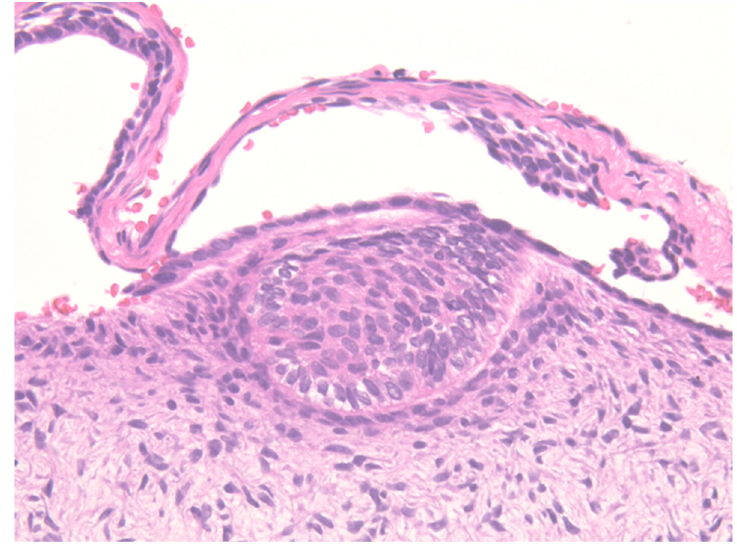
Figure 4. Histological findings of primordial odontogenic tumor. Nests of epithelium resemble dental lamina, and columnar epithelial cells show reverse nuclear polarization (200×). Immunohistochemistry revealed vimentin expression in the epithelium and mes- enchymal component, whereas syndecan-1 (CD138) and Bcl-2 were not expressed in the epithelium and mesenchymal component (Figure 5). According to histological and im- munohistochemical findings, we diagnosed the patient as having POT. After the operation, the second molar erupted. Recurrence was not observed at the 11-month follow-up.